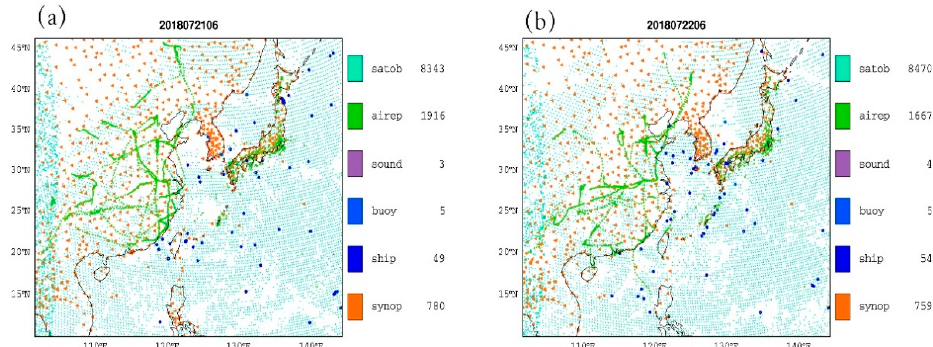
Figure 4. Distribution of GTS observations at ( a ) 0600 UTC on 21 July 2018, ( b ) 0600 UTC on 22 July 2018. SATOB (satellite atmospheric motion vector), Airep (aircraft data), SOUND (radiosondes).